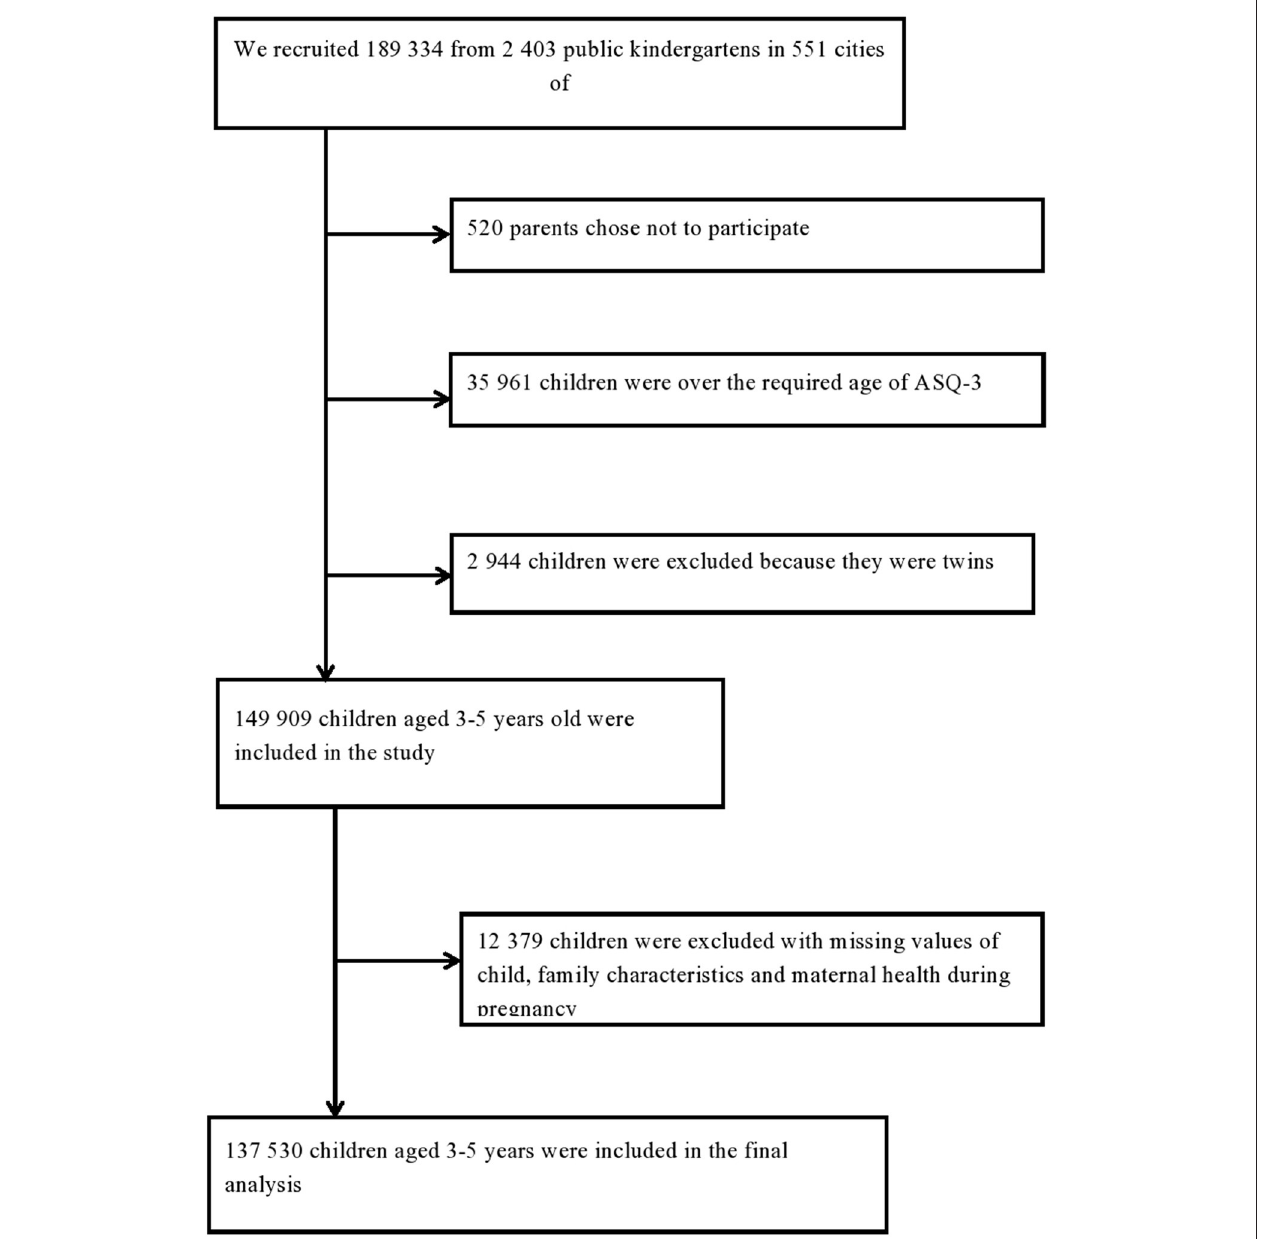
FIGURE 1 | Flowchart of the study